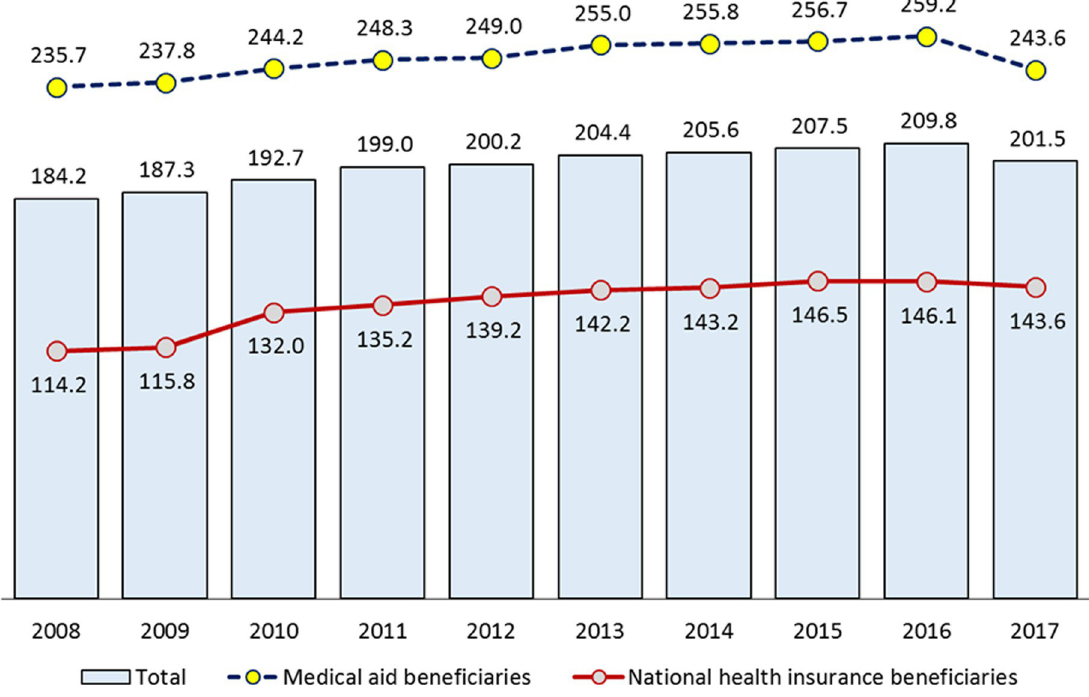
Fig 1. Length of hospital stay for schizophrenia, schizotypal and delusional disorders by medical coverage type, 2008–2017. (Unit: